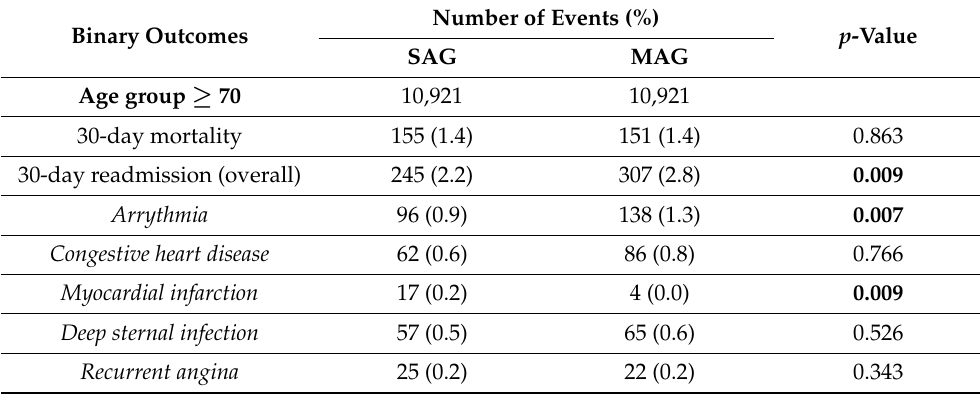
Table 2. Short-term outcomes of patients undergoing single arterial and multiple arterial grafting after propensity score